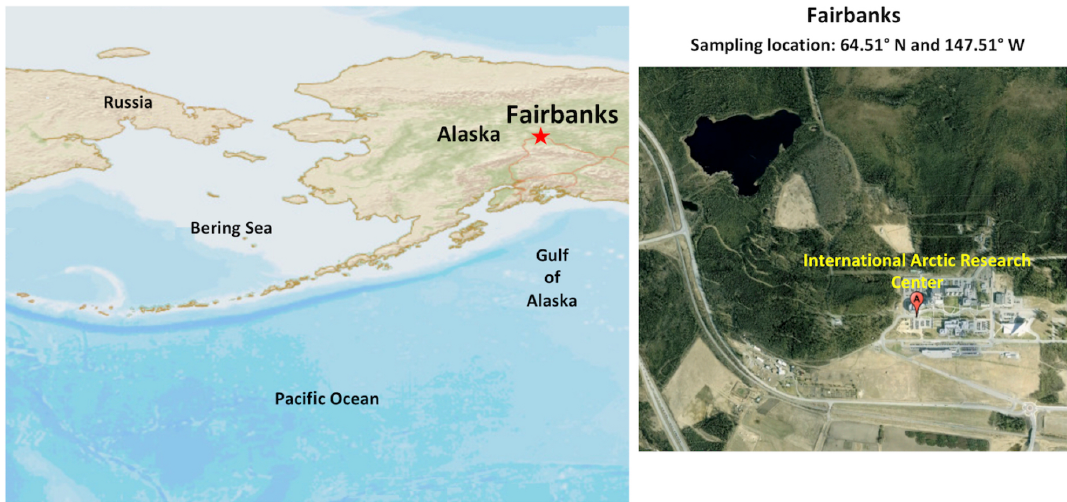
Figure 1. The location of the sampling site at Fairbanks in central Alaska (64.51 ◦ N and 147.51 ◦ W) and its surrounding regions. The map was downloaded from Map data © 2018 Google.